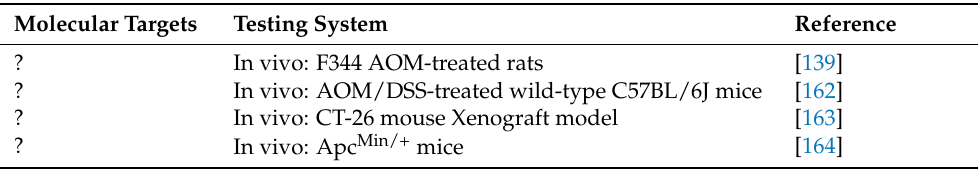
Table 7. Reported targets of quercetin active in decreasing the number of tumor nodules of CRC models alongside their in vivo testing system. “?” denotes the lack of specific targets in the respective